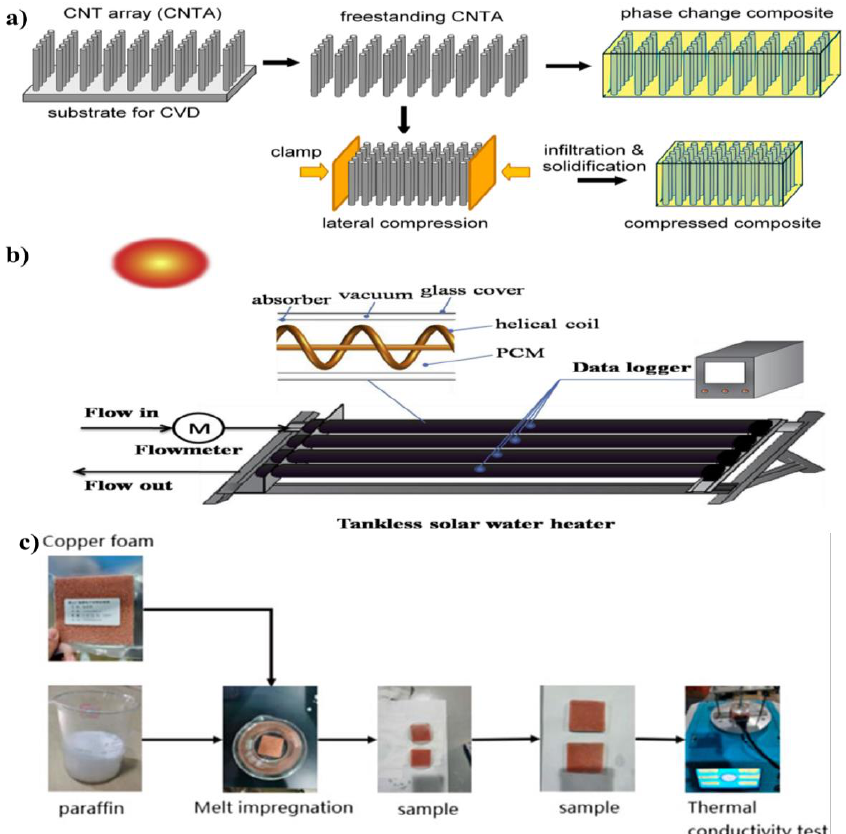
Figure 7. ( a ) CNT arrays with compressible alignment and PCC [79], ( b ) [80], and ( c ) the process of fabrication of copper foam/paraffin PPC [81]. Reproduced with permission.